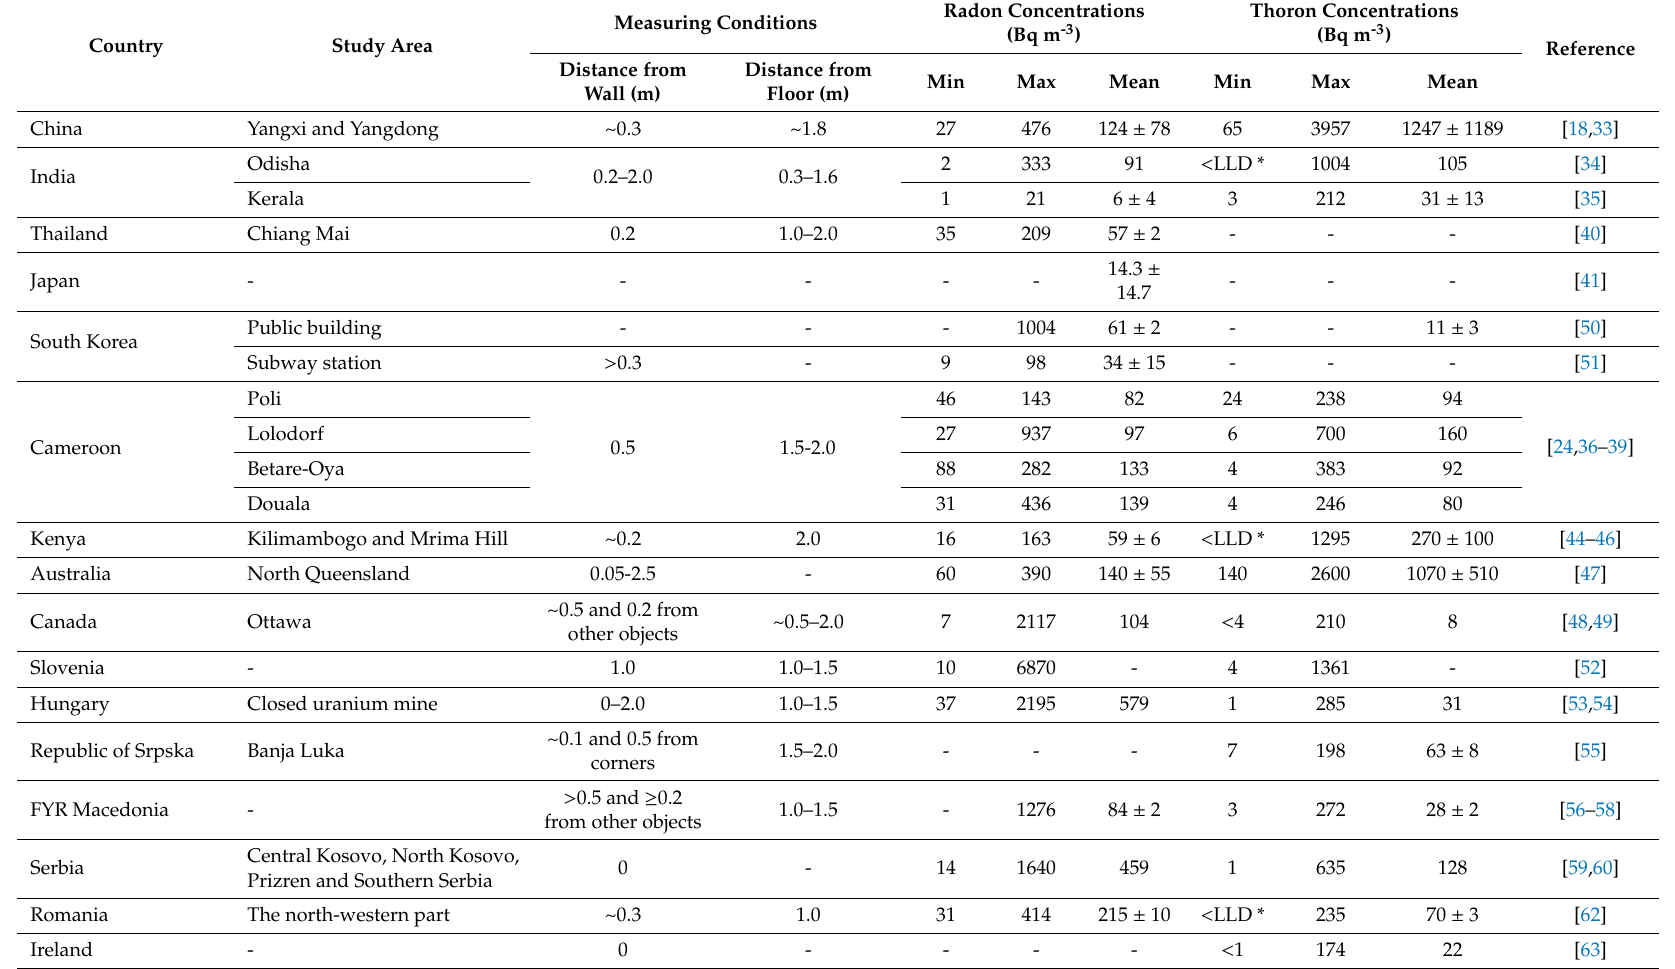
Table 1. Summary of the results obtained using RADUETs for radon and thoron surveys in various